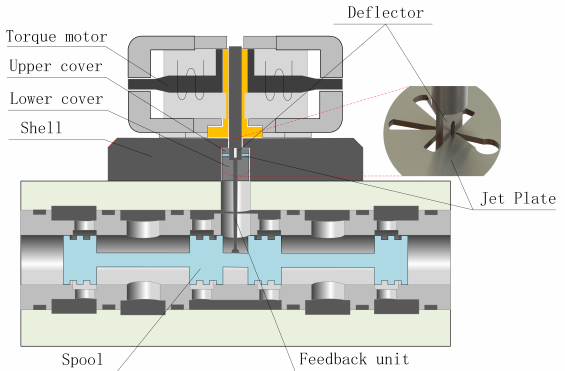
Figure 2. Function of hydraulic amplifier in whole